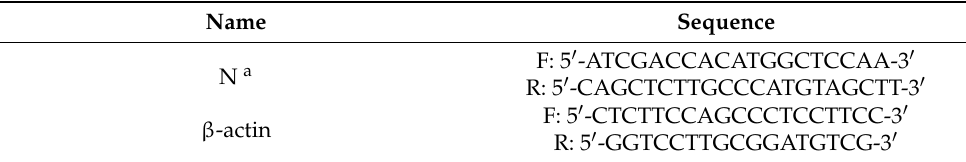
Table 2. Primers for quantitative real-time